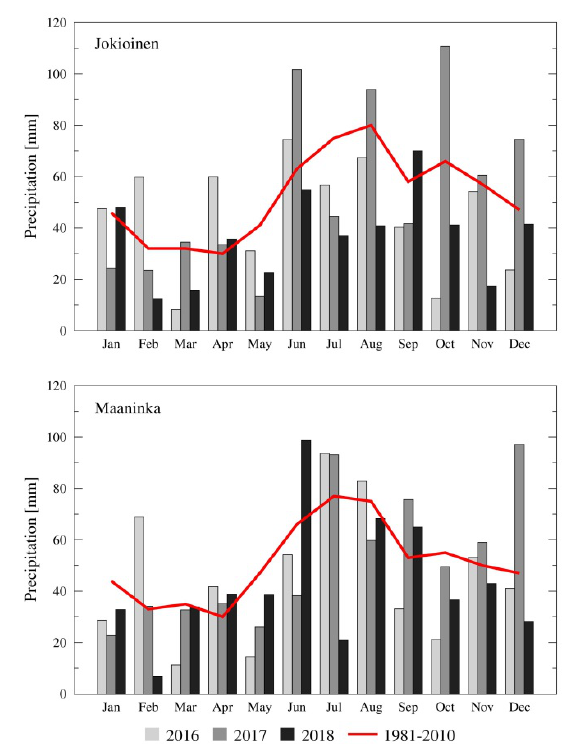
Fig. 2. Mean monthly precipitation in the study period (2016−2018) and long-term average for the normal period (1981–2010) in Jokioinen and